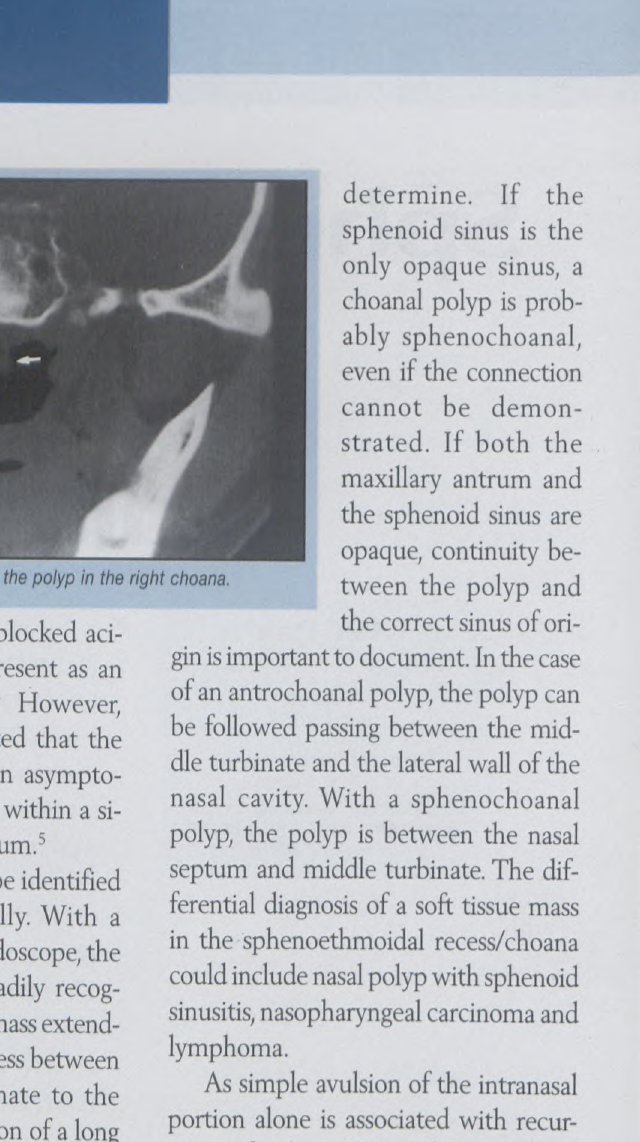
Figure ~: The polyp (arrow) Is seen in the right nasopharynx. The right sphenoid SinUS IS opaque and there Is associated reactive